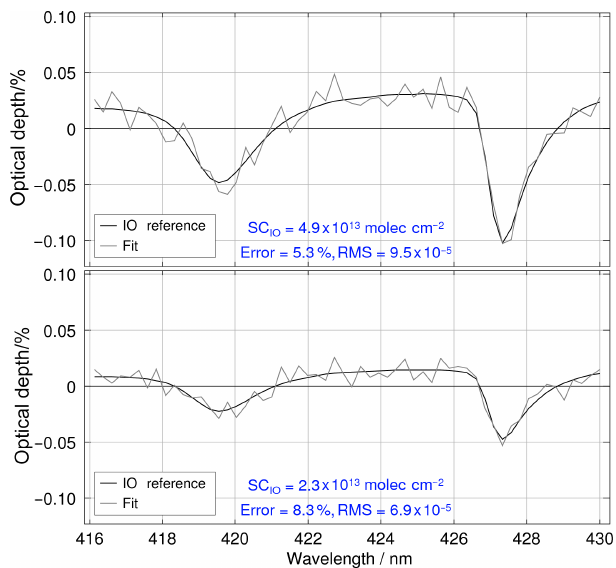
Figure 1. Example fitting results from SCIAMACHY on day 11 August 2008, with two different IO slant column amounts recorded at 55.34 ◦ N, 220.21 ◦ E (top) and 54.90 ◦ N, 215.92 ◦ E (bottom). The fit (grey) shows the measurement optical depth after all other fea- tures except for the IO absorption (black) have been subtracted. The optical depth RMS values are 9.5 and 6 . 9 × 10 − 5 ,